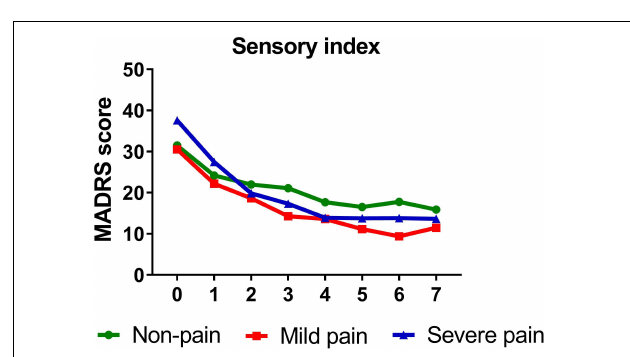
FIGURE 5 | Overall change in MADRS score across six infusions. Pain severity was defined by present pain intensity. Patients exhibiting no pain symptom were characterized as “non-pain,” patients exhibiting the mean or below the mean present pain intensity were characterized as “mild pain” and patients exhibiting above the mean present pain intensity were characterized as “severe pain.” MADRS, Montgomery-Åsberg Depression Rating Scale. Numbers on X -axis: 0 represents baseline, 1 ∼ 6 represent the next morning after each infusion, 7 represents 2 weeks after infusions (Day